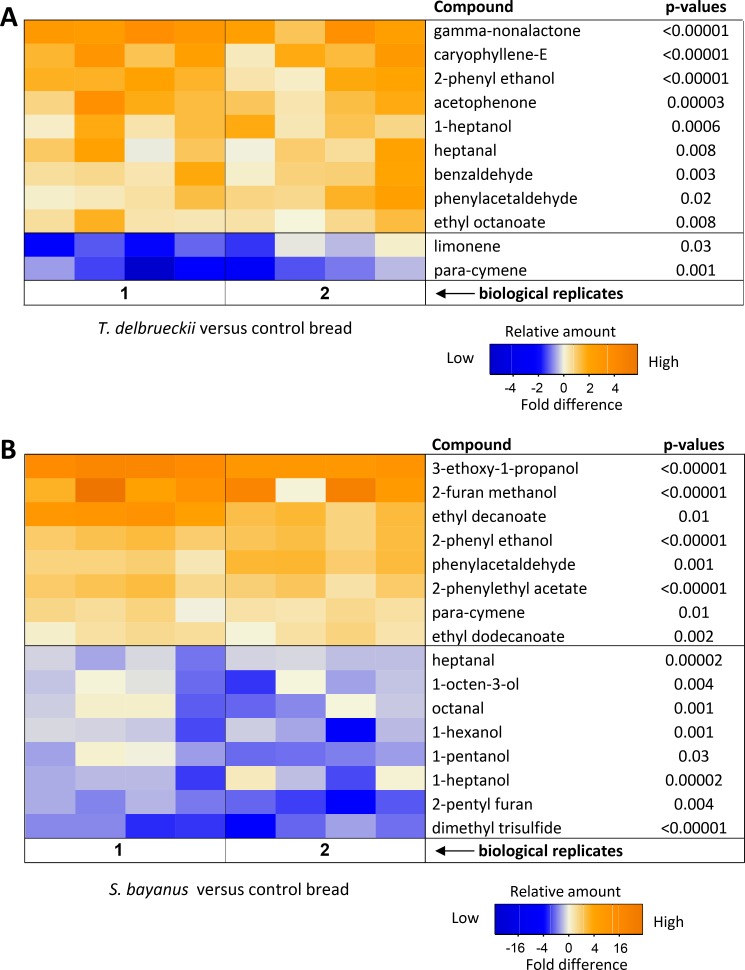
Heatmaps illustrating the differences in relative concentrations of volatile compounds in bread crumb prepared with nonconventional yeasts (A) Torulaspora delbrueckii (Y273) and (B) S. bayanus (Y156) compared to bread produced with a commercial baker strain (control). Data are based on HS-SPME-CG-MS analysis of two biological replicates with four technical replicates each. Color codes indicate the fold difference in log2-transformed relative peak areas of each compound, between samples and their controls. P-values were obtained using a linear mixed models and Tukey posthoc analysis, in which biological replicate and treatment were coded as random and fixed factors.